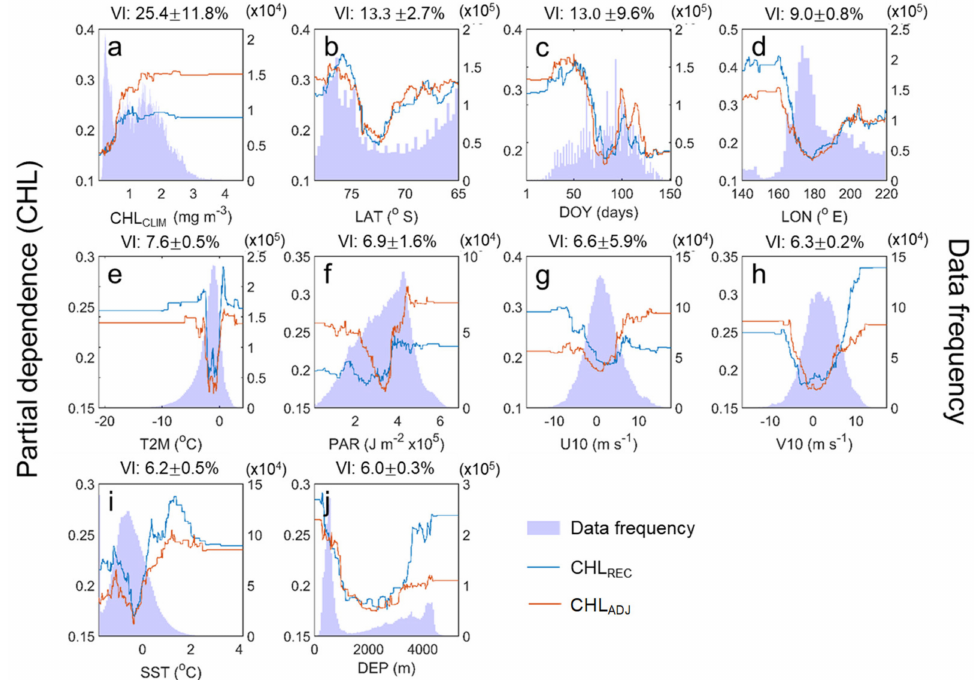
Figure 12. PDP (on the left y-axis) of the CHL reconstruction (light blue: CHL REC , orange: CHL ADJ ) for all predictors in order of the variable importance (VI): ( a ) CHL CLIM , ( b ) LAT, ( c ) DOY, (d) LON, ( e ) T2M, ( f ) PAR, (g) U10, (h) V10, ( i ) SST and (j) DEP. Light blue bars (on the right y-axis) indicate the data distribution of predictors at certain bins (500 bins). Numeric values on the top of each window indicate the VI (mean ± standard deviation,%) of the predictor obtained from the machine-learning